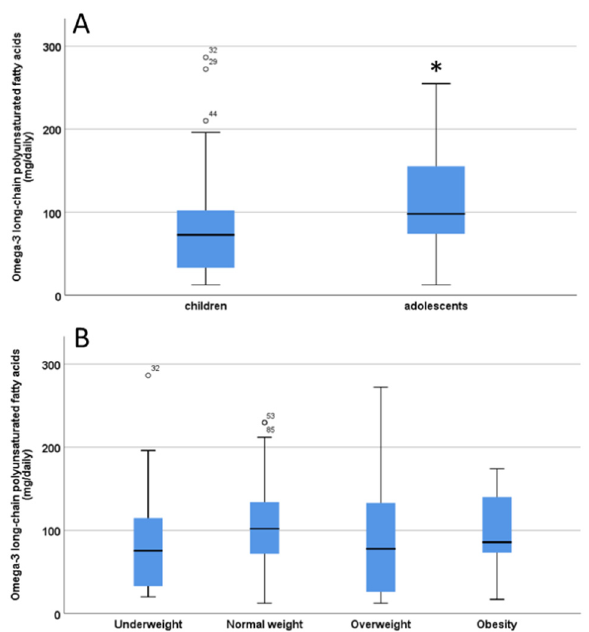
Figure 2. Estimation of omega-3 long chain polyunsaturated fatty acids (LC-PUFA) intake from fish/seafood in children and adolescent ( A ) and body weight categories ( B ). The significant difference in Panel A is indicated by the asterisk * p < 0.05. ° indicate outliers defined as a data points located outside the whiskers of the box plot.